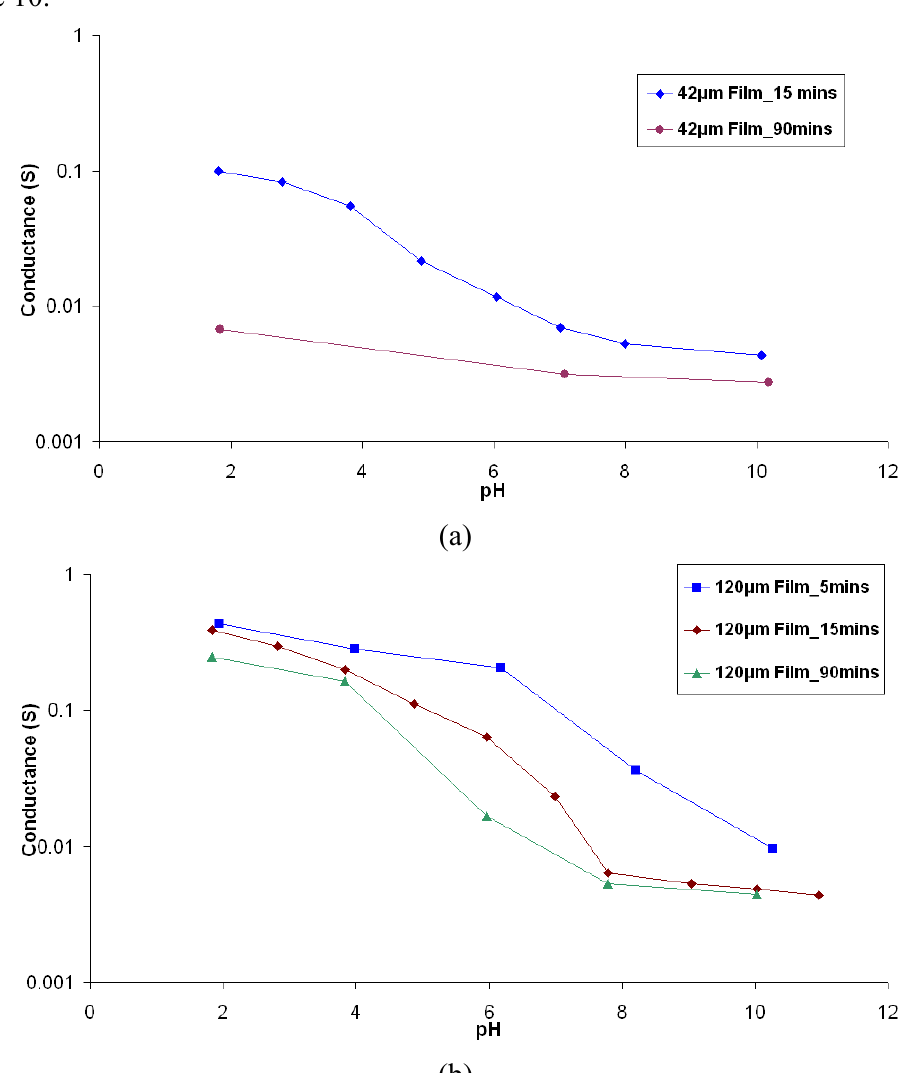
Figure 10. Plots showing the change in conductivity of PANI composite thick films when films are in contact with the test solutions for (a) 42 µm; and (b) 120 µm thick